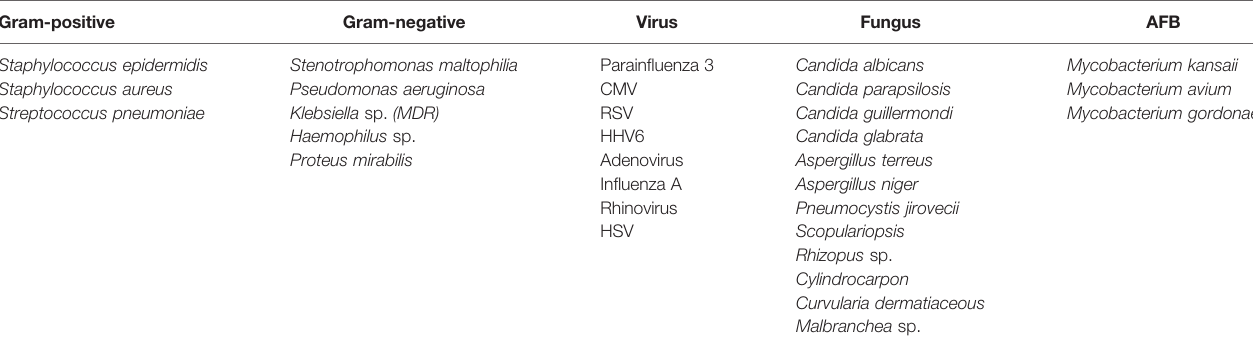
TABLE 6 | Most common organisms retrieved from bronchoalveolar lavage samples.